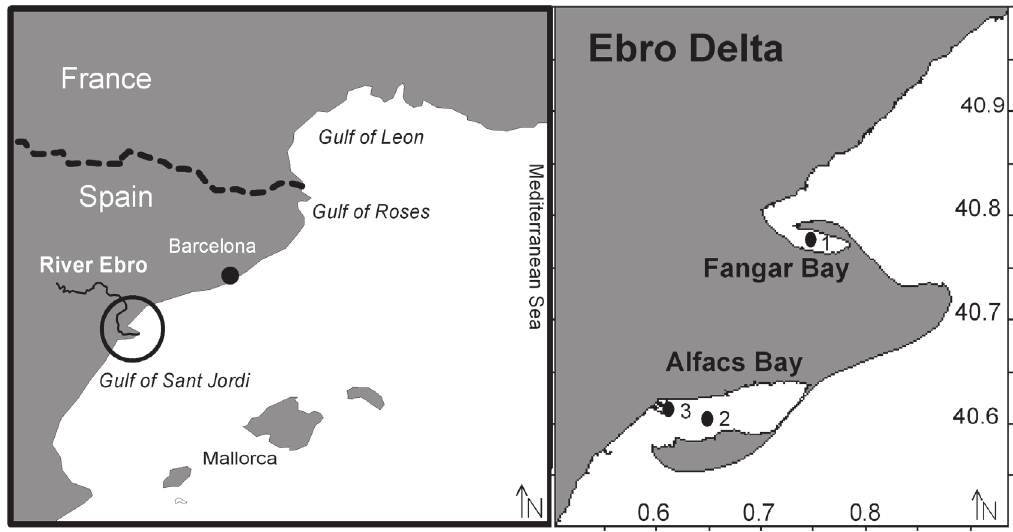
Fig . 1. – Study area showing the location of sampling stations in alfacs and Fangar Bays, nW Mediterranean